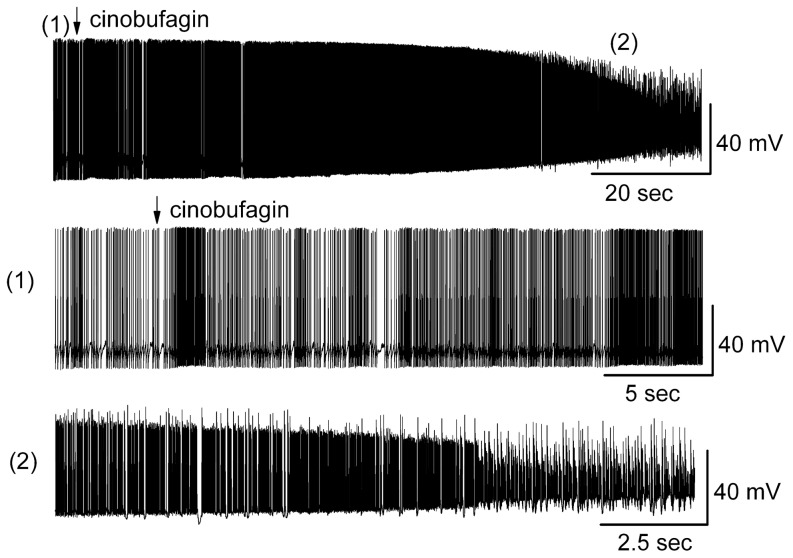
Over-excitation of MC evoked by cinobufagin.Arrow indicates the time point of adding 10 µM cinobufagin. The recording trace at the (1) and (2) time point in the upper trace are shown at an extended time scale in the middle trace and lower trace.